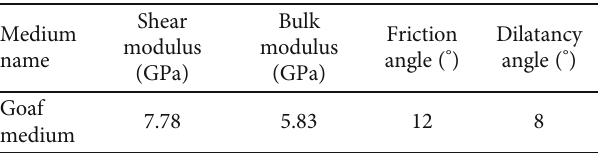
Table 2: Mechanical parameters of the goaf medium in the double- yield model.